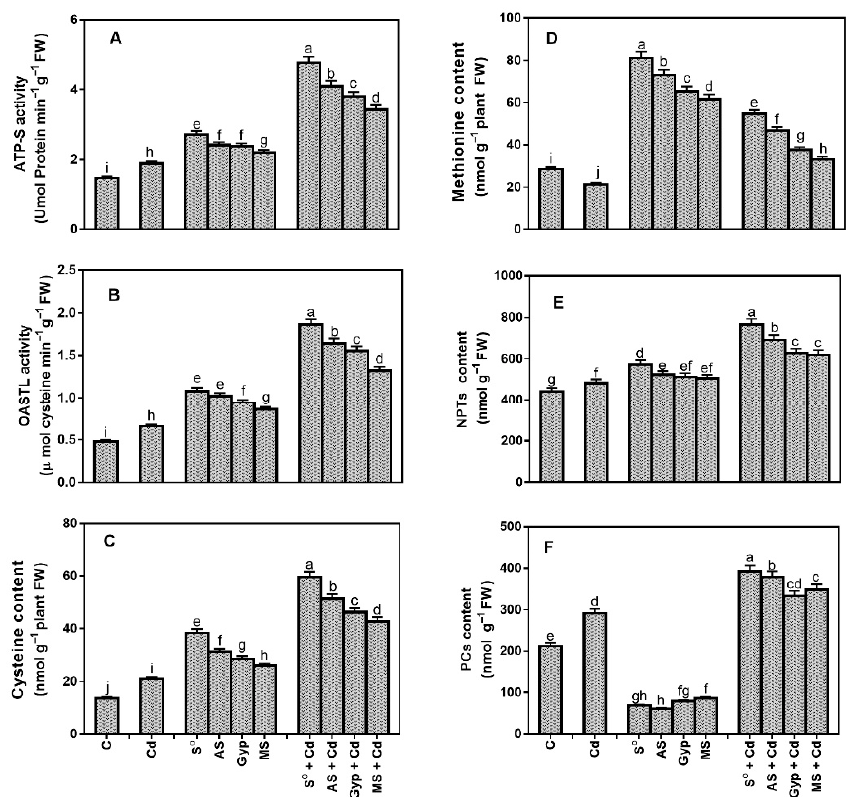
Figure 6. Foliar ( A ) ATP-S activity, ( B ) OASTL activity, ( C ) Cys content, ( D ) Met content, ( E ) NPT content, and ( F ) PCs content in Brassica juncea cv. Giriraj treated with 200 mg S kg − 1 soil of elemental S (S 0 ), ammonium sulfate (AS), gypsum (Gyp), and magnesium sulfate (MS), grown with or without cadmium (200 mg Cd kg − 1 soil). Data are presented as means ± SE ( n = 4). Data with the same letter are not significantly different by LSD test at p < 0.05. ATP-S, ATP sulfurylase; C, control; Cd, cadmium; FW, fresh weight; NPTs, non-protein thiols; OASTL, O-acetylserine (thiol) lyase; PCs, phytochelatins. NPT and PCs content was analyzed in leaves of both stressed and unstressed